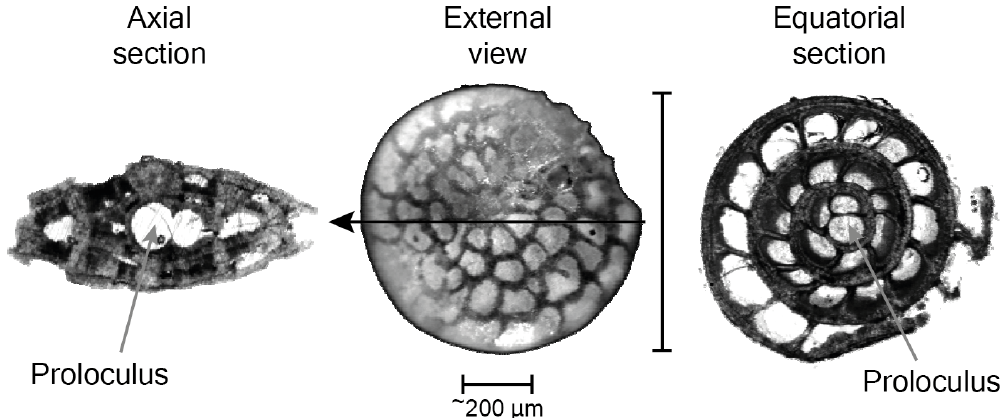
Figure 1. The equatorial and axial orientation of larger foraminifera thin section samples (foraminifera images from Cotton,